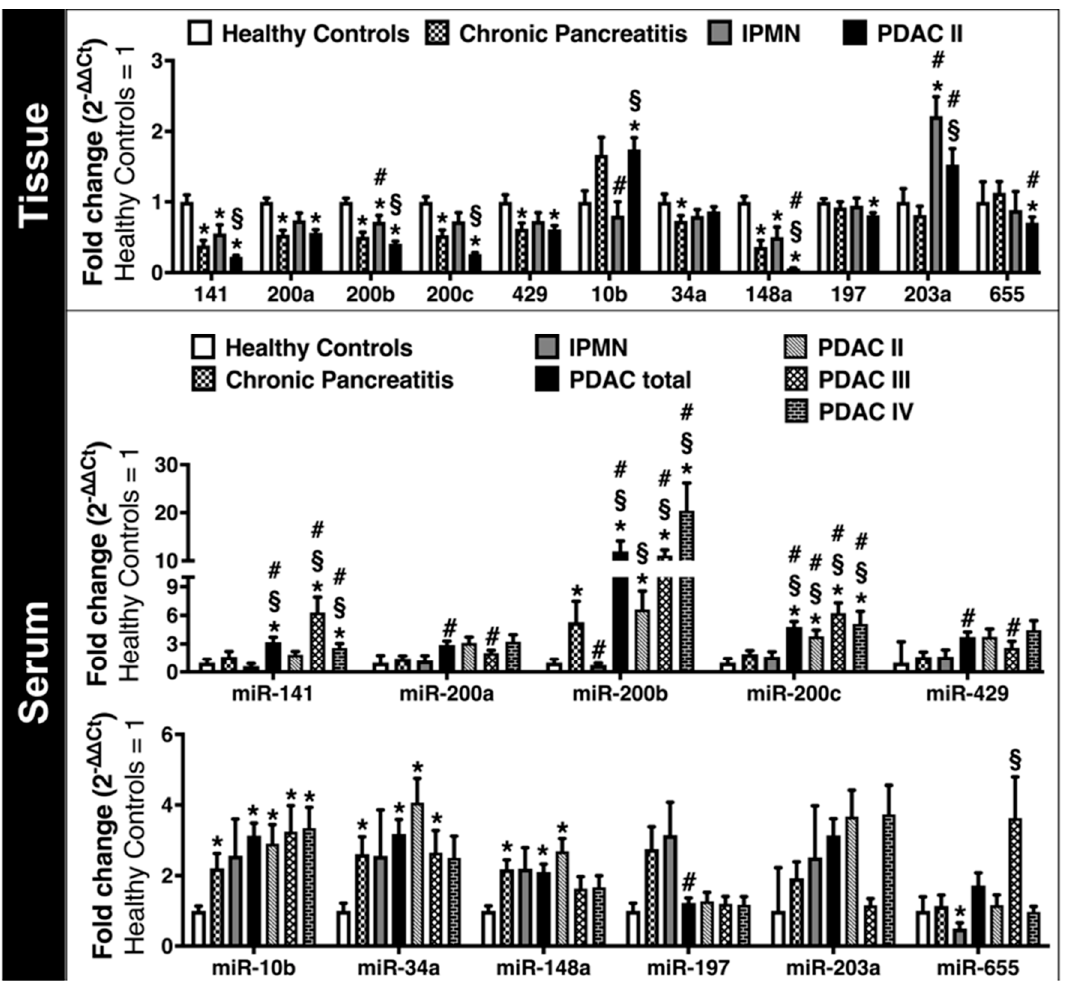
Figure 2. EMT-regulating microRNAs in human pancreatic tissue and blood serum samples. Fold change values for tissue and blood serum samples analyzed with qRT-PCR and interpreted with the ΔΔ Ct-method. Data expressed as the mean ± SEM. * indicates significance ( p ≤ 0.05) against healthy controls; # against chronic pancreatitis and § against intraductal papillary mucinous neoplasm (IPMN).